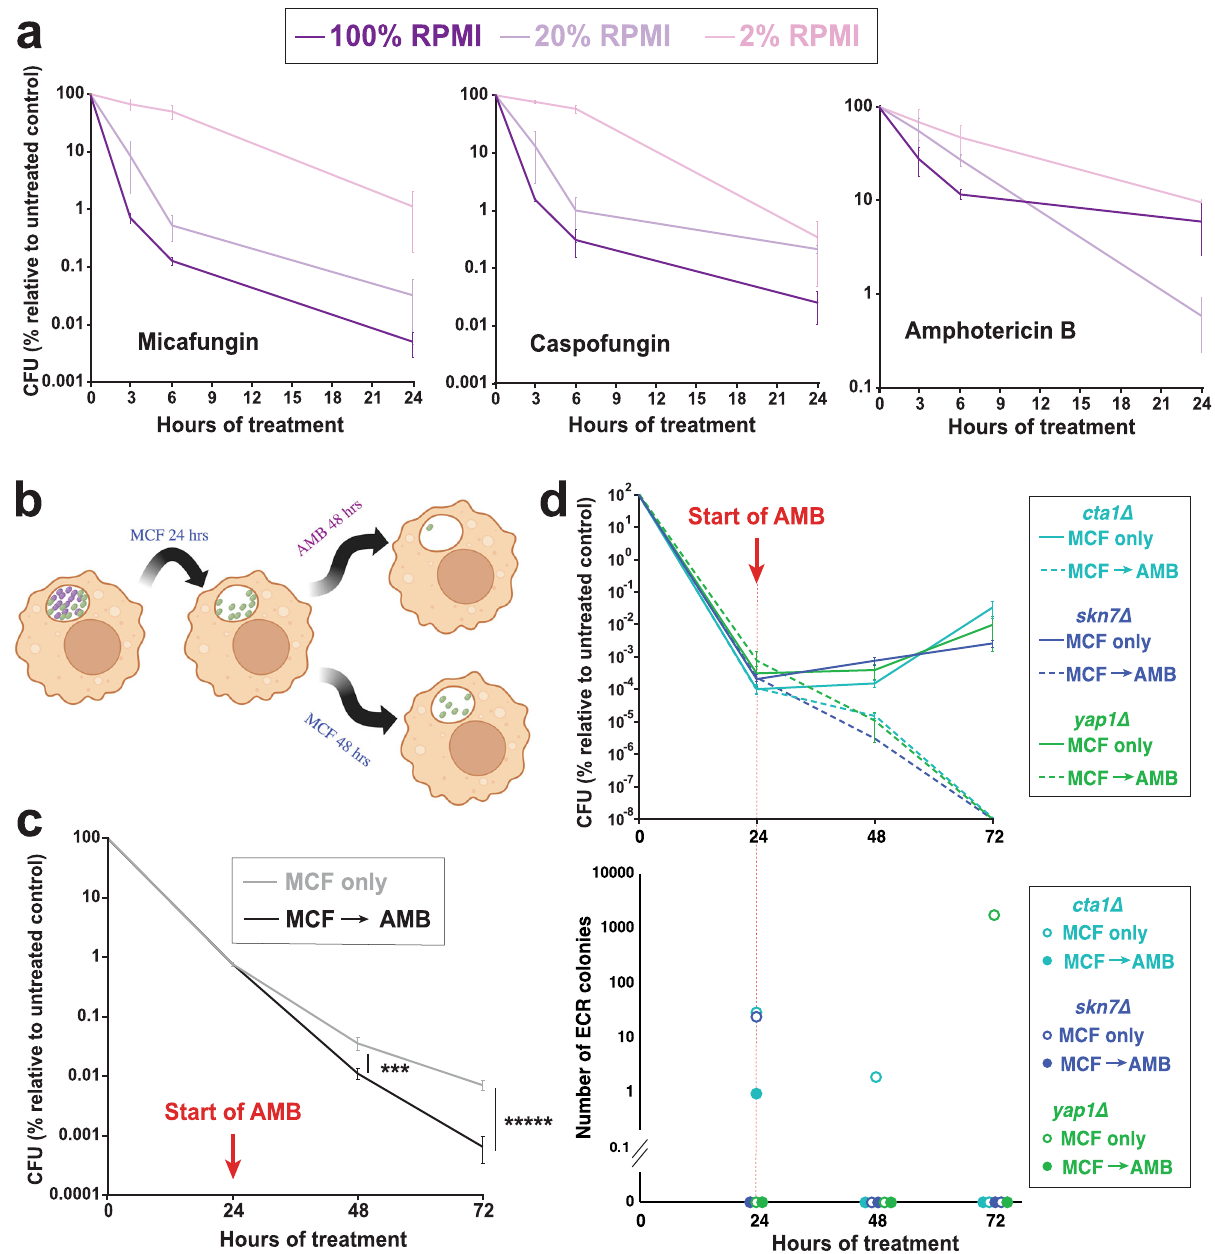
Fig.6|AmphotericinBef fi cientlykillsechinocandinpersisters.a Themetabolic dependencies of micafungin, caspofungin, and amphotericin B were assessed by incubating C. glabrata (CBS138) at various dilutions of RPMI (100%, 20%, and 2%). a Micafunginandcaspofunginkillingef fi cienciesweremuchmoreaffectedbyRPMI concentration than that of amphotericin B. n =6 biological replicates over 3 inde- pendent experiments. b ICG were treated with micafungin (0.125 µ g/ml) for 24h, fungin (0.125 µ g/ml), and survival rates were monitored for the next